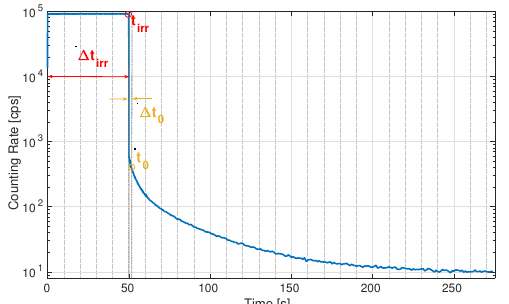
Figure 2: Typical irradiation run of the ALDEN experi- ment The average counting rate during the irradiation phase is given by Figure 3: LOENIE long counter with its 16 3 He